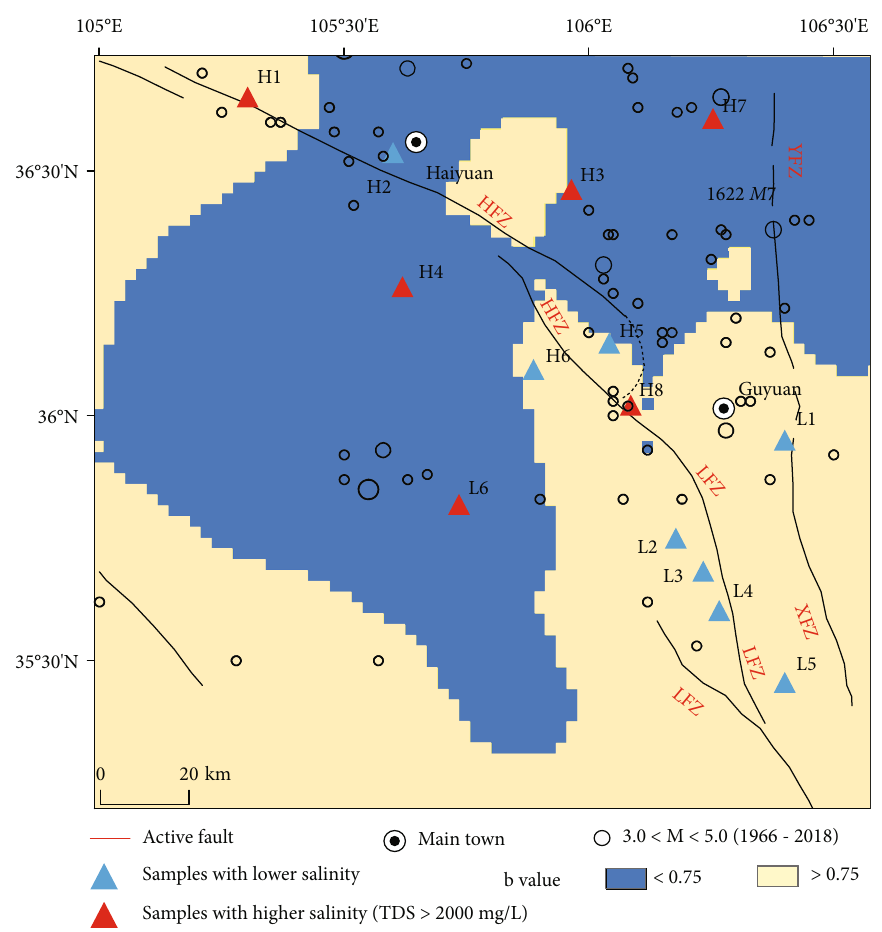
Figure 7: The spatial distribution of b value in the